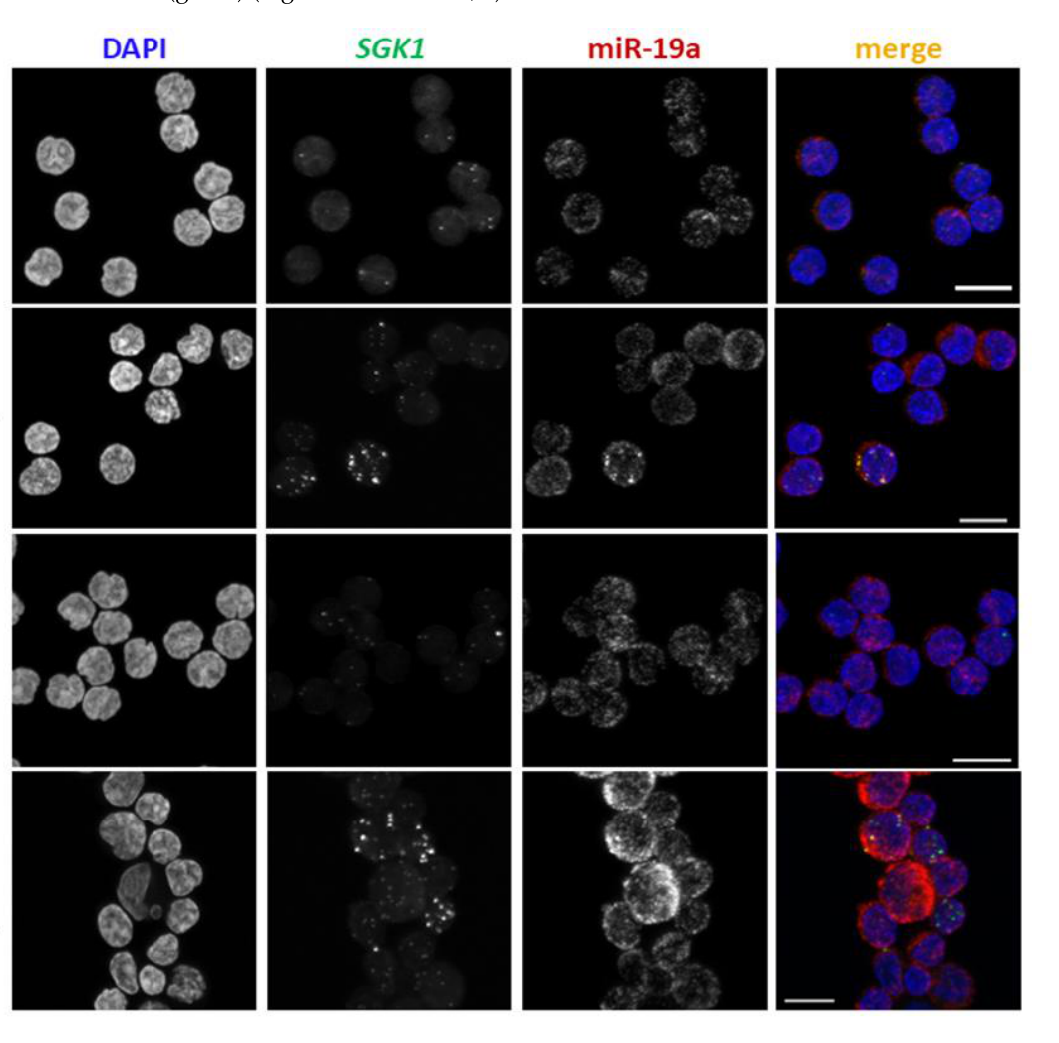
Figure 4. SGK1 intensity is increased in α CD3 α CD28 treated CD4+ T cells. Cells for imaging were hybridized with the PrimeFlow probes against SGK1 mRNA and miR-19a miRNA and stained with DAPI to identify cell nuclei. Individual images for each probe and condition are shown: α CD3 α CD28 ( α CD3/CD28), dexamethasone (DEX), α CD3 α CD28 and dexamethasone ( α CD3/CD28+ DEX), medium alone (PBS vehicle). Representative images were selected for each condition. n = 3 individuals. Scale bar = 10 µ